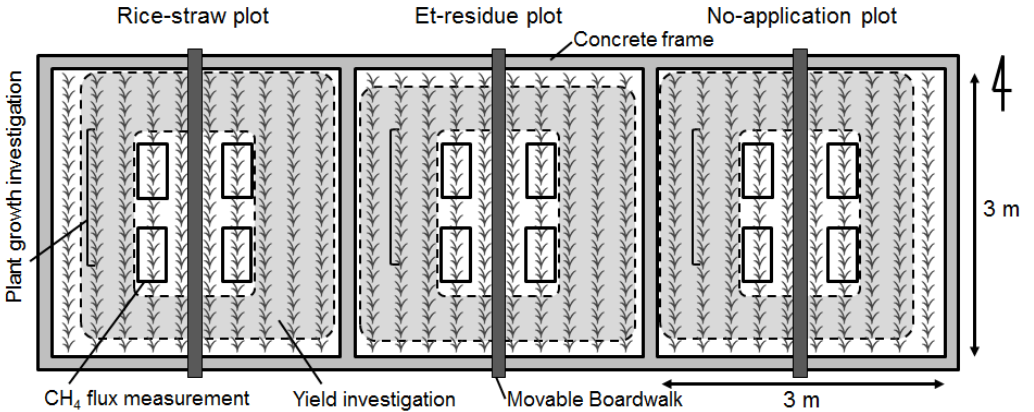
Figure 1. Layout drawing of experimental plots (In the case of 2011). Boardwalks were placed just for each flux measurement.